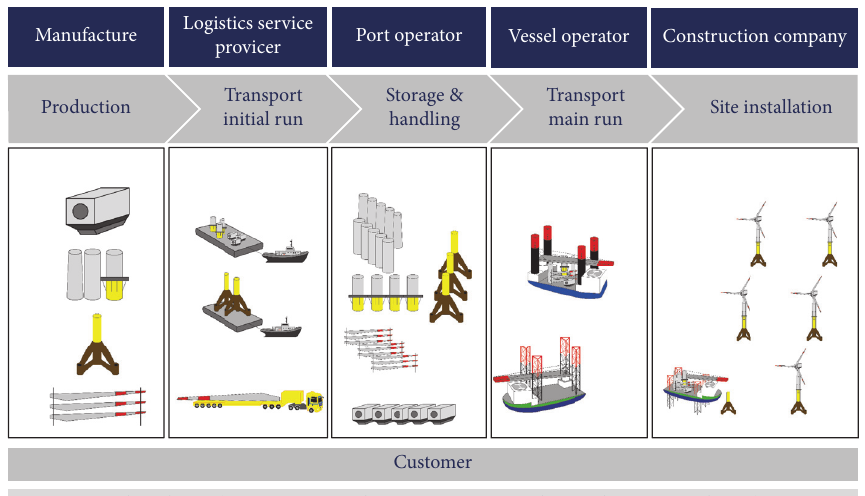
Figure 1: Logistics network of an offshore wind farm project (based on